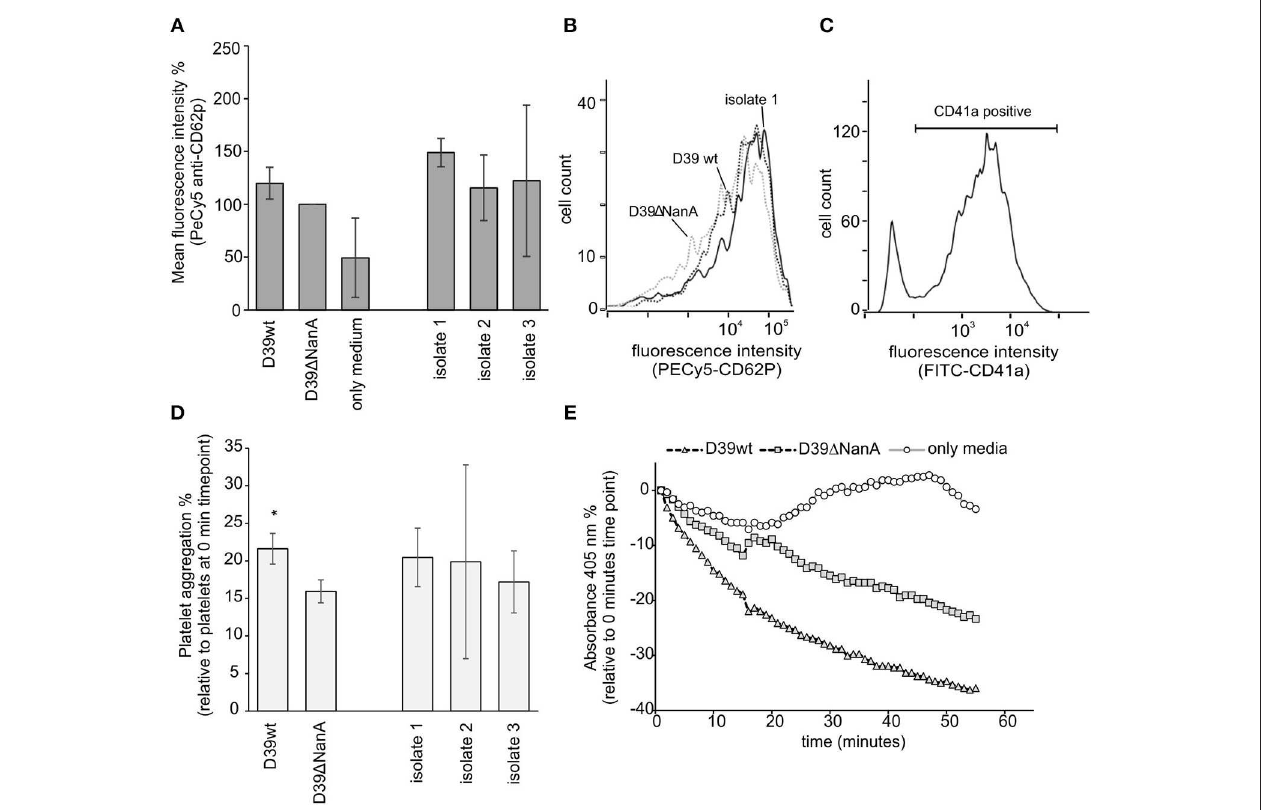
FIGURE 4 | Effect of S. pneumoniae NanA expression on platelet activation and aggregation. (A–C) Bacterial culture supernatants from S. pneumoniae D39 wild type (D39 wt), D39 mutant and three clinical isolates (isolate 1–3) were incubated in citrate anticoagulated whole blood. (A) Activation of platelets was detected by analyzing the expression of CD62P (P-selectin) by flow cytometry ( n = 3). Intensity levels are calculated as relative mean fluorescence intensity against CD62P expression by D39 1 NanA supernatant treated cells. (B) A histogram showing distribution of CD62P-binding on platelets in the presence of supernatants from D39 wt, D39 1 NanA and isolate 1. (C) Gating of platelets using anti-CD41a antibody. (D) To detect platelet aggregation platelets were isolated and the samples were treated with hirudin plasma after 10min incubation with bacterial supernatant ( n = 3). Aggregation of platelets was determined by subtracting the absorbance values at 0 time point from the absorbance values at the end time point shown in (E) . Statistical significances are calculated against (A) CD62P expression or (D) aggregation between D39 1 NanA and D39 wild type supernatant treated cells using one-way ANOVA (* P -value < 0.05). Error bars indicate SD.